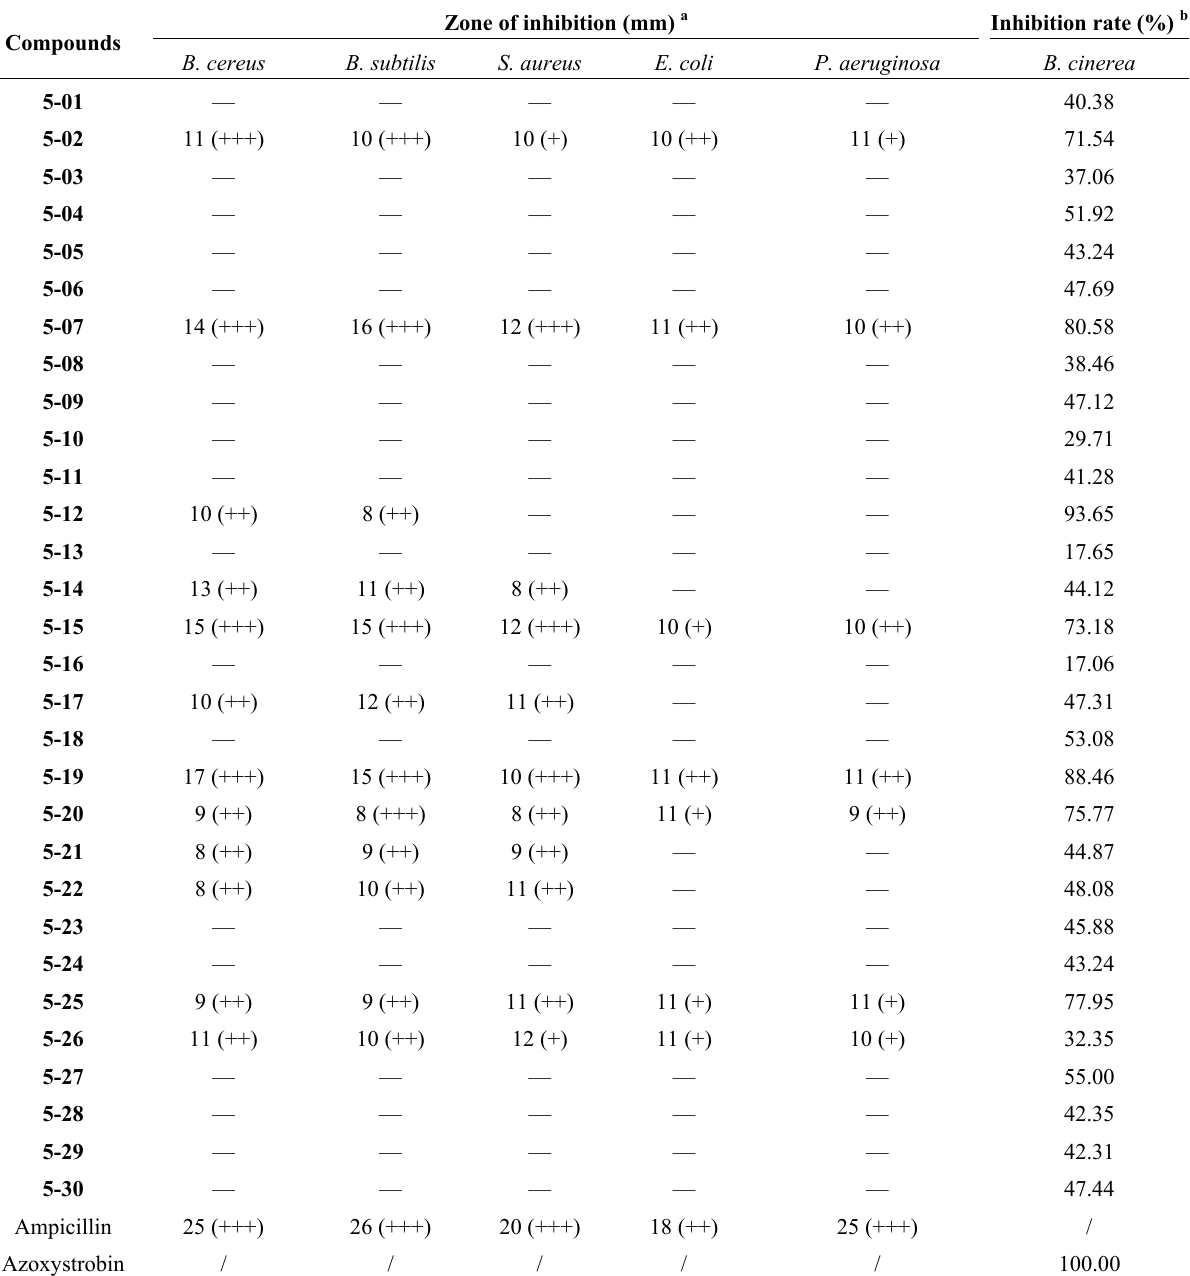
Table 1. Antimicrobial activity of title